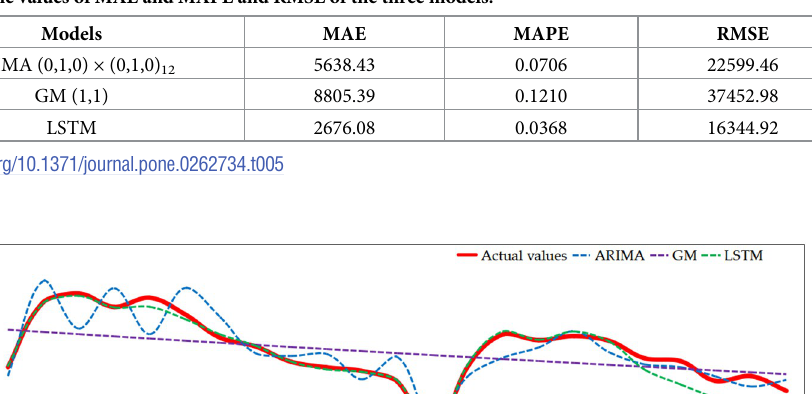
Table 5. The values of MAE and MAPE and RMSE of the three models.